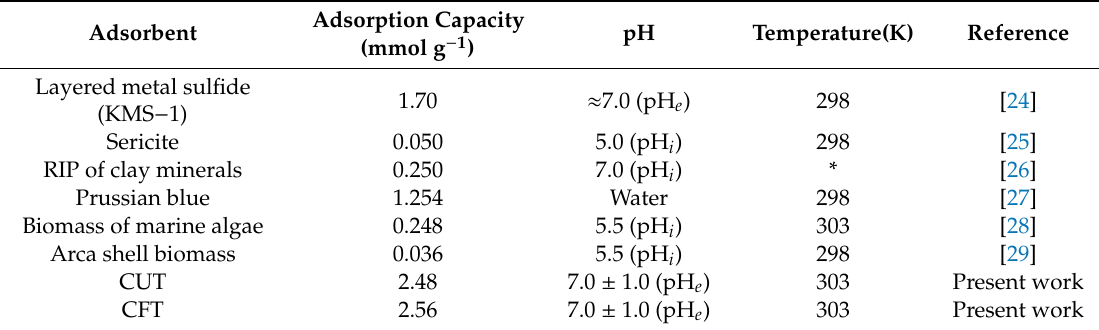
Table 3. Comparisons of adsorption capacities of present adsorbents with various kinds of other adsorbents for Cs + ion reported in the